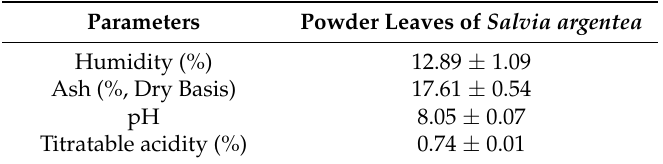
Table 1. Physicochemical parameters of the leaf powder of Salvia argentea .